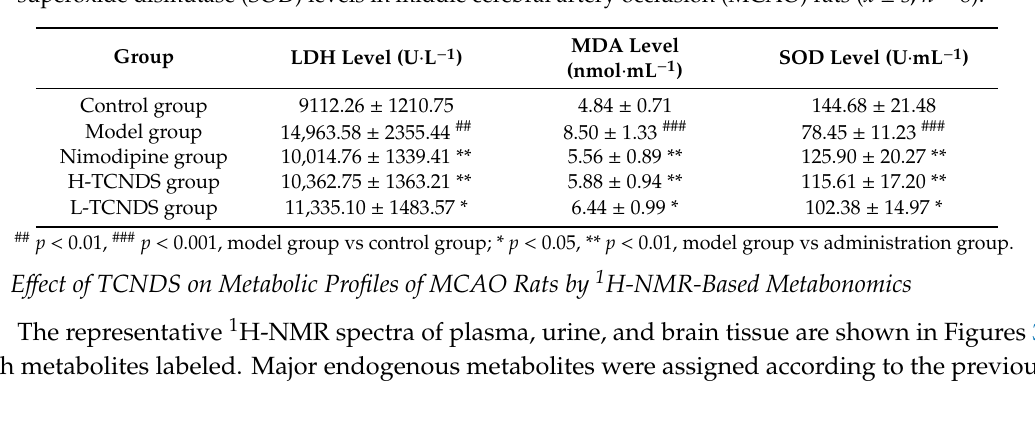
Table 2. E ff ect of TCNDS on plasma lactate dehydrogenase (LDH), malondialdehyde (MDA) Table 2. Effect of TCNDS on plasma lactate dehydrogenase (LDH), malondialdehyde (MDA) and